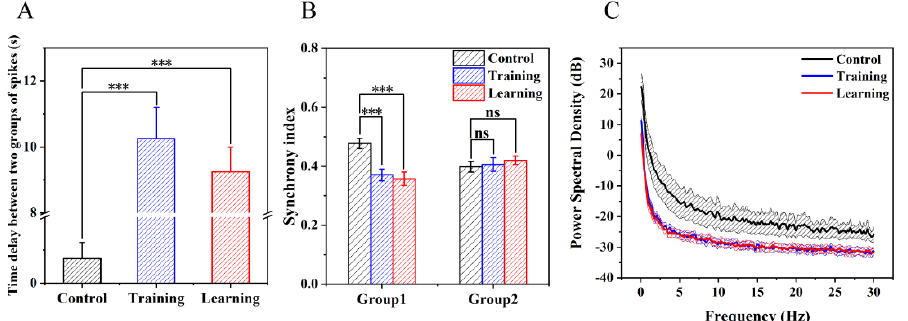
Figure 9. Electrophysiological statistical analysis of two types of neurons at the network level. ( A ) Time delay between spikes of the neurons the two types of neurons. ( B ) The average synchrony index of neurons in excitatory neurons and inhibitory neurons before, during, and after training. ( C ) The power of LFP before and after training ( n = 5, *** p <